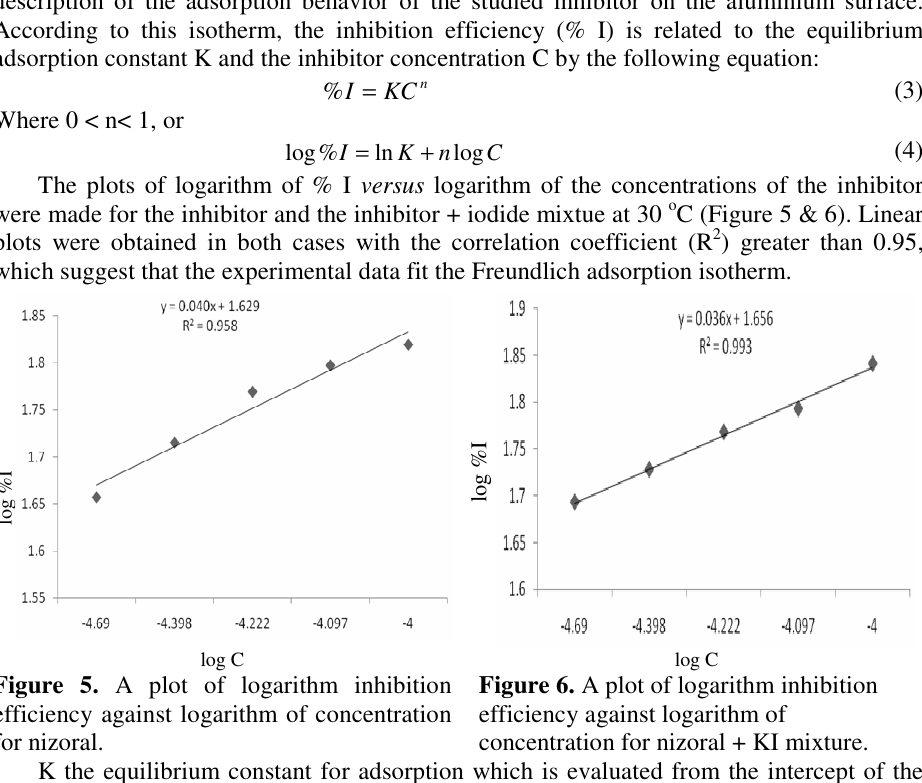
Figure 5. A plot of logarithm inhibition efficiency against logarithm of concentration for nizoral.